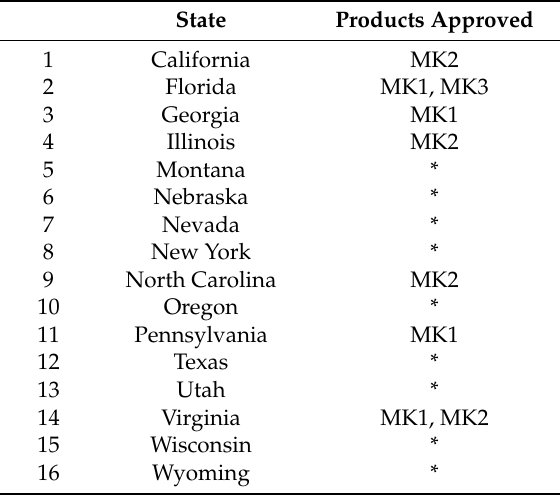
Table 1. Metakaolin products used in this study and approved for use in U.S.